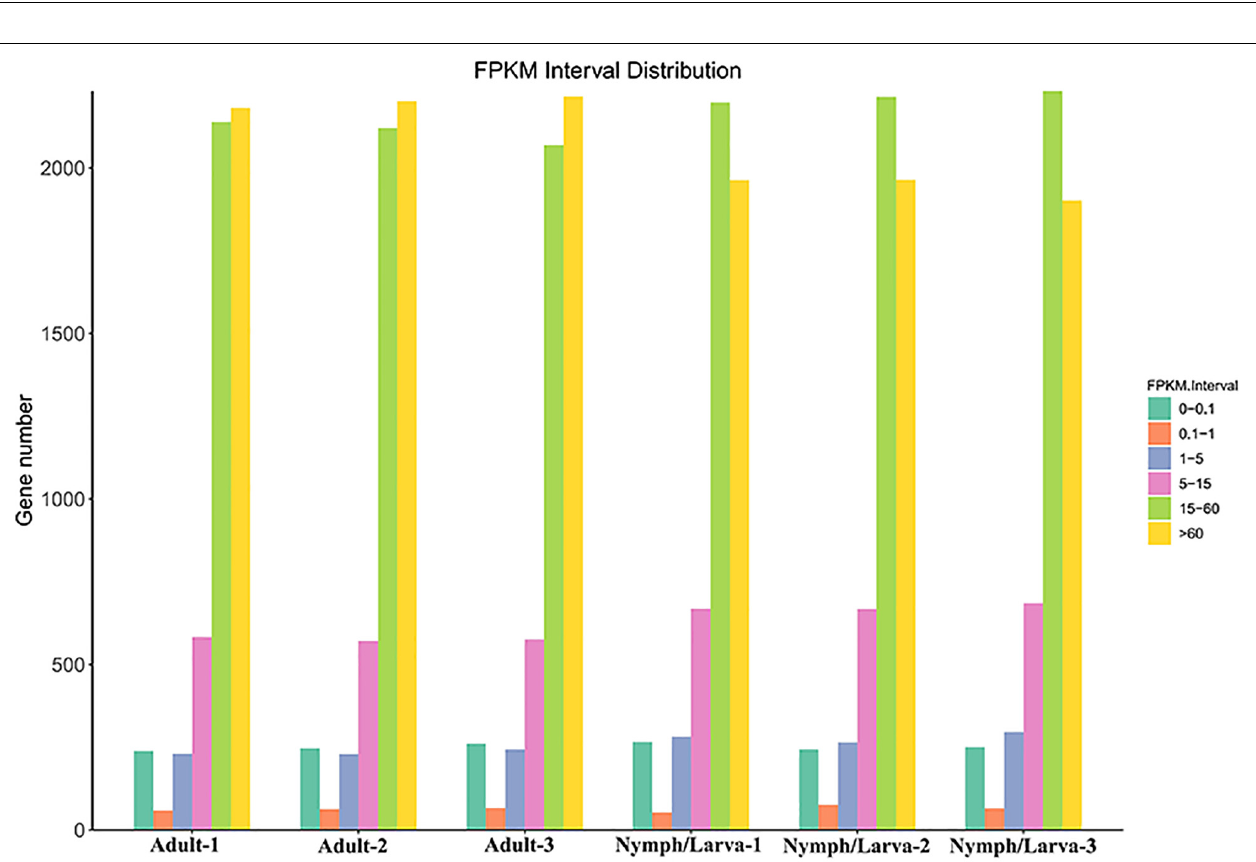
FIGURE 3 | The gene numbers for different Fragments Per Kilo-base of transcript per Million mapped reads (FPKM) values of adult mites vs . nymph/larva mites.